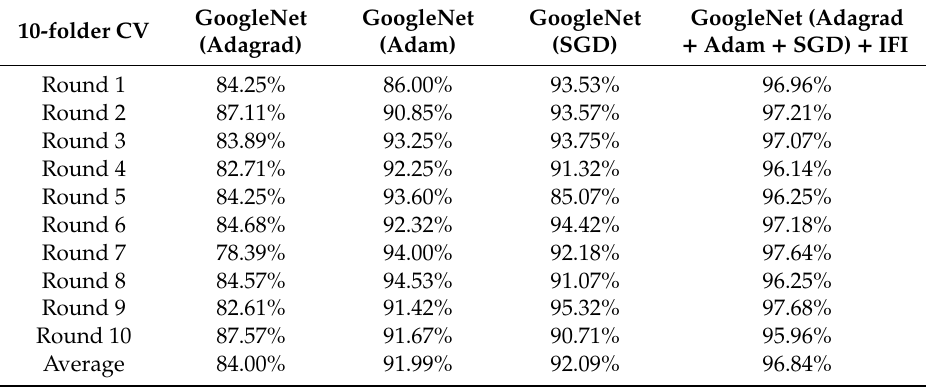
Table 5. Recognition results of GoogleNet architectures with di ff erent optimization method.